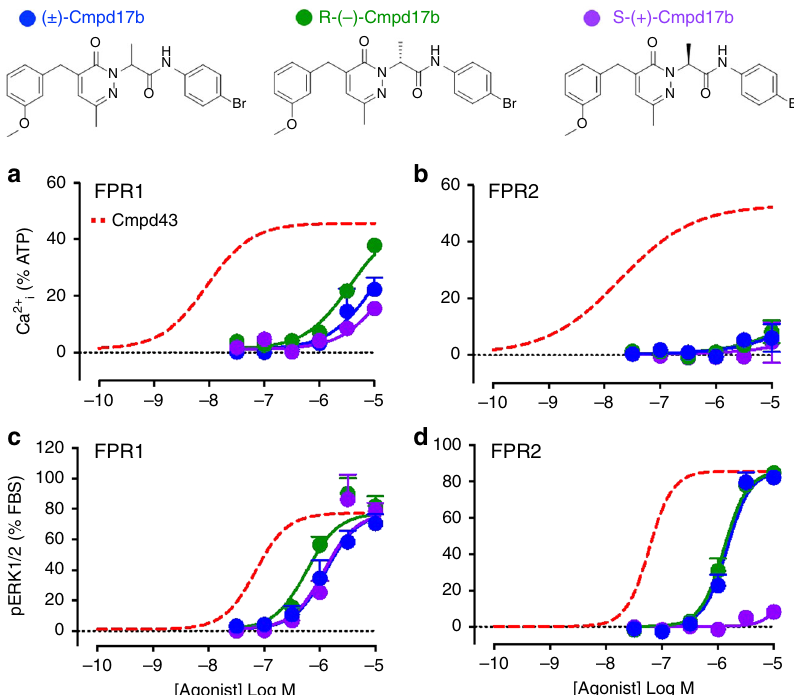
Fig. 1 Signalling fi ngerprint of R,S-( ± )Cmpd17b and its enantiomers in CHO cells stably expressing hFPRs. In fl uence of R,S-( ± )Cmpd17b (blue), R-( − ) Cmpd17b (green) and S-(+)Cmpd17b (purple) on intracellular signalling intermediates downstream of GPCRs. Concentration – response curves to Ca 2+ i mobilisation at a hFPR1 and b hFPR2. Concentration – response curves to ERK1/2 phosphorylation at c hFPR1 and d hFPR2. Responses to all three compounds were determined concomitantly, with n = 3 – 7 separate experiments, each performed in duplicate or triplicate. Results are expressed as mean ± S.E.M. The red dashed line illustrates non-linear regression for the reference FPR agonist Cmpd43 from our original publication 6 . The chemical structure of Cmpd17b ( N -(4-bromophenyl)-2-[5-(3-methoxybenzyl)-3-methyl-6-oxo-6H-pyridazin-1-yl]-propionamide), illustrating the position of the chiral centre, is shown on the upper panel